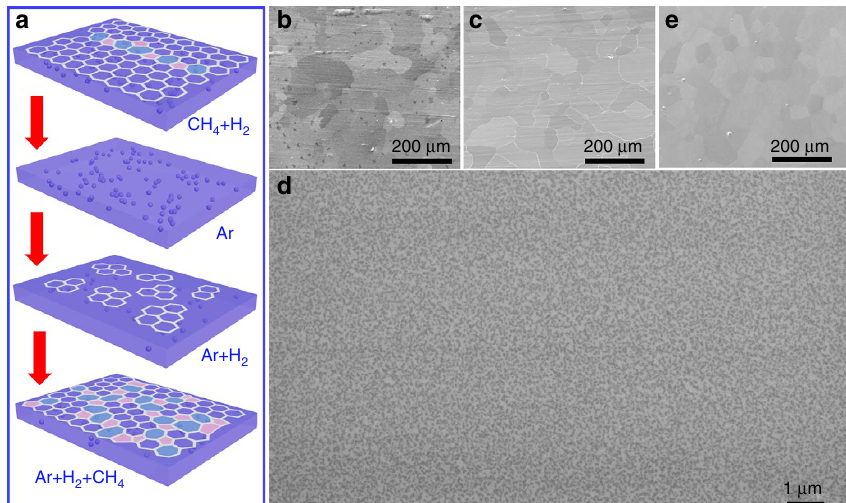
Figure 1 | SACVD growth of polycrystalline graphene films with well-controlled grain sizes. ( a ) Schematic for the fabrication process of a polycrystalline graphene film. ( b ) Scanning electron microscope (SEM) image of a graphene film, mostly monolayer, grown on Pt with a mixture of hydrogen (700standard-state cubic centimetre per minute, sccm) and methane (7sccm) for 10min. ( c ) SEM image of the Pt substrate in b after treating with pure argon (700sccm) for 20min, showing that the graphene film has disappeared. ( d ) SEM image of the Pt substrate in c after treating with a trace of hydrogen (5sccm) for 20min, showing that many small graphene domains have appeared. ( e ) SEM image of a monolayer polycrystalline graphene film formed from d by introducing a low flow rate of methane (0.1sccm) for 1h. The reaction temperature was all 900 (cid:2) C in above